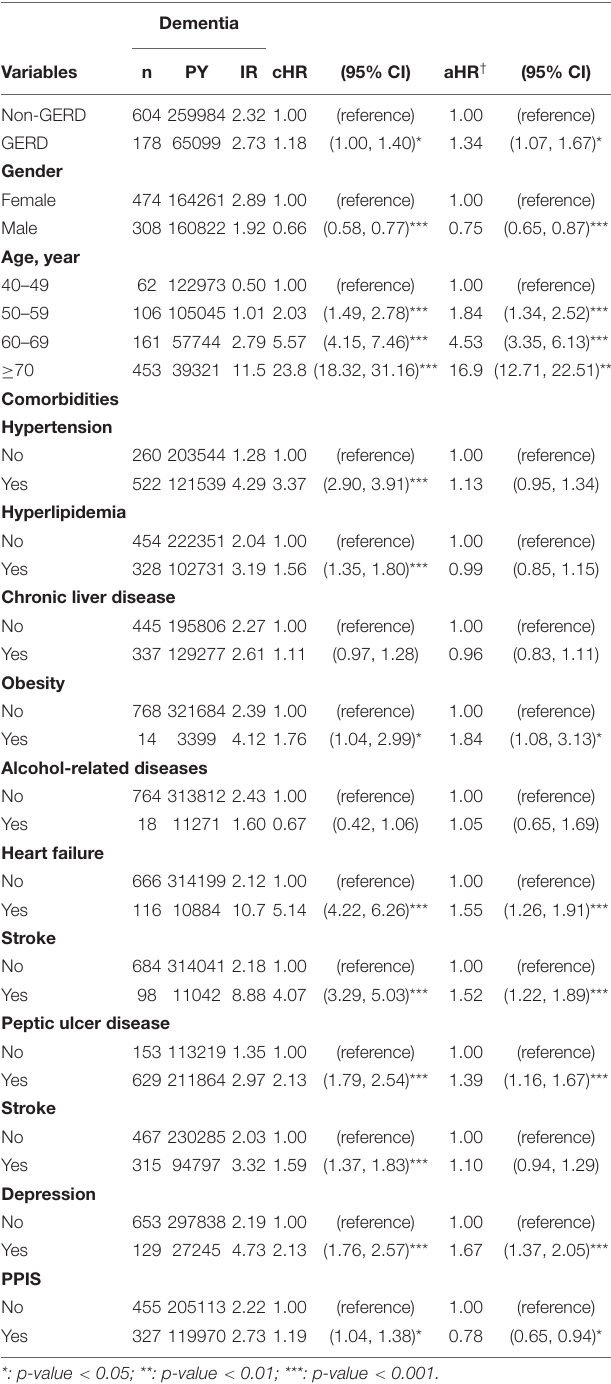
TABLE 2 | Cox proportional hazard model